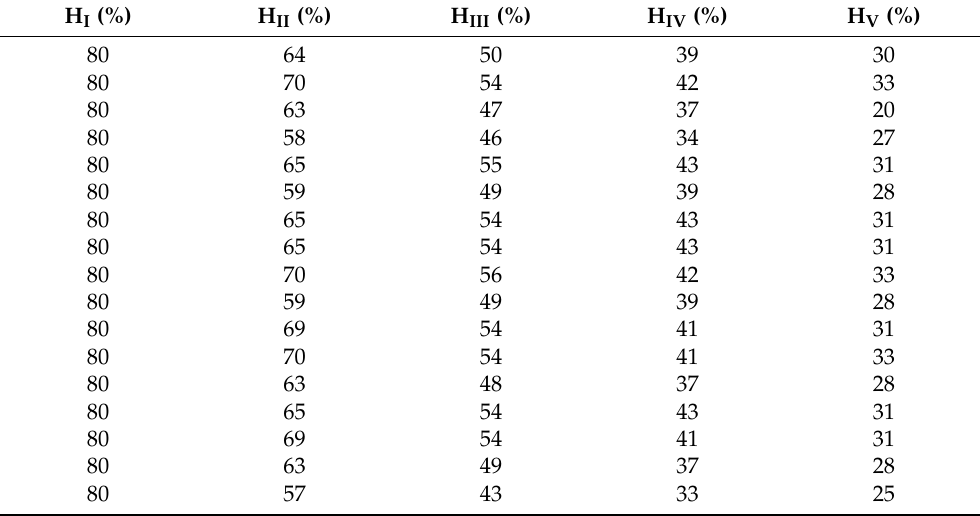
Table A2. Impulse heights on the ultrasonic flaw detector screen—determination of measurement errors in the glue joint